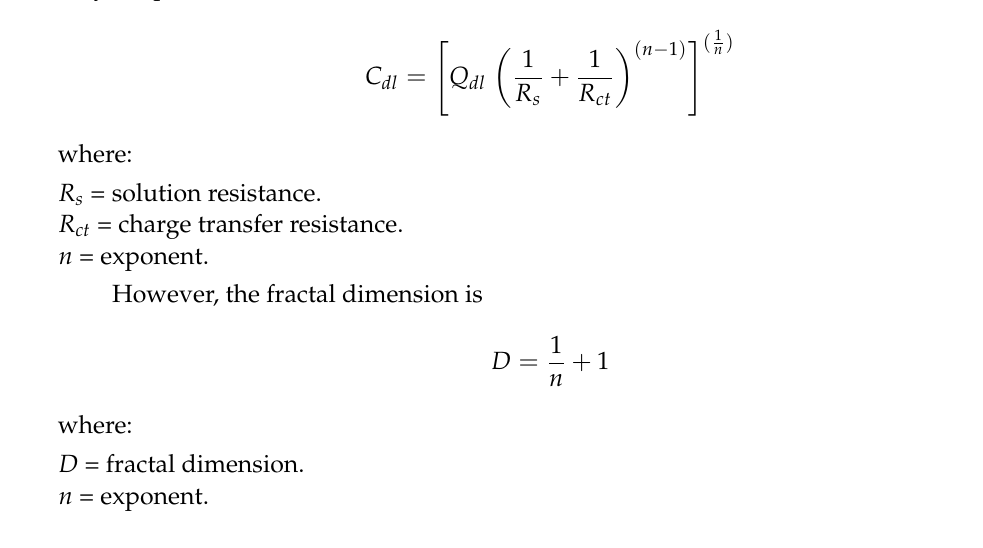
Table 1. CPE parameters ( Q and n ), resistance, effective capacitance, and fractal dimension of the API X60 steel in 3.5% w / v NaCl solution, at pH = 5.0, in the presence and absence of caffeine as a corrosion inhibitor.